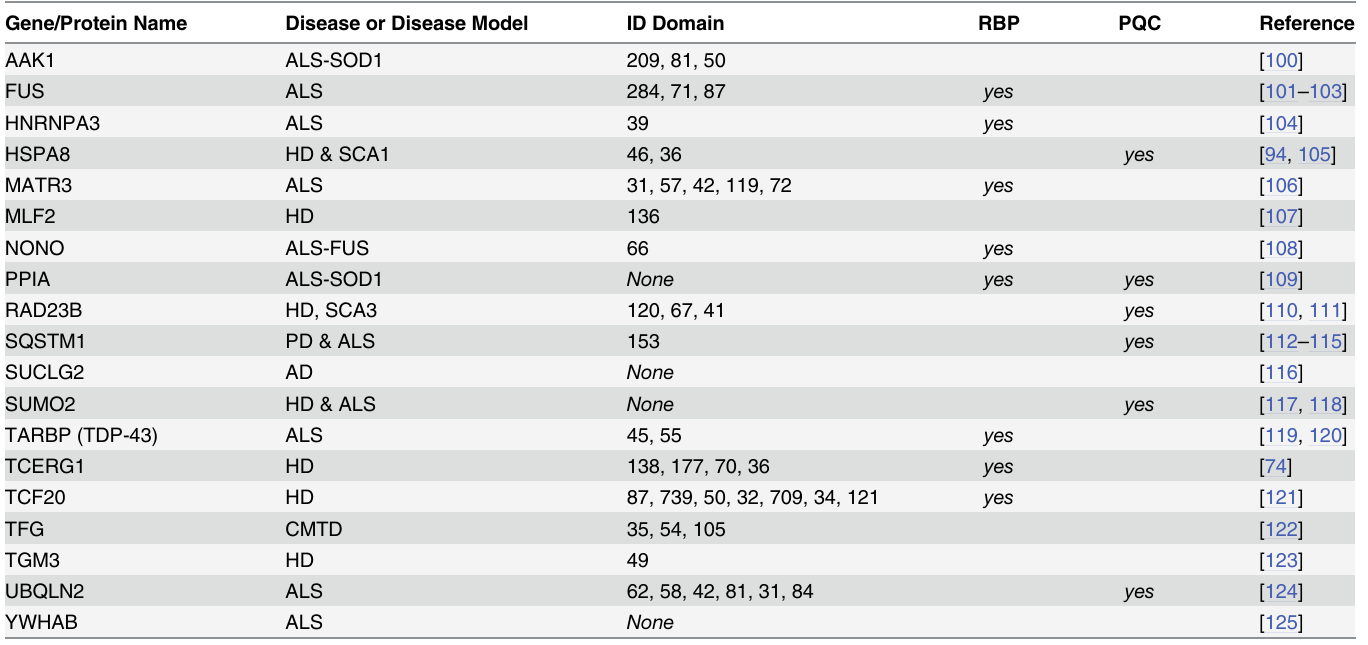
The numbers for ID Domains indicate the length of distinct unstructured regions (cid:1) 30, for the identi fi ed rat proteins from PC-12 cells, as determined by IUPred-L. RBP = RNA-binding protein as described in the legend of Table 2; PQC = protein quality control.